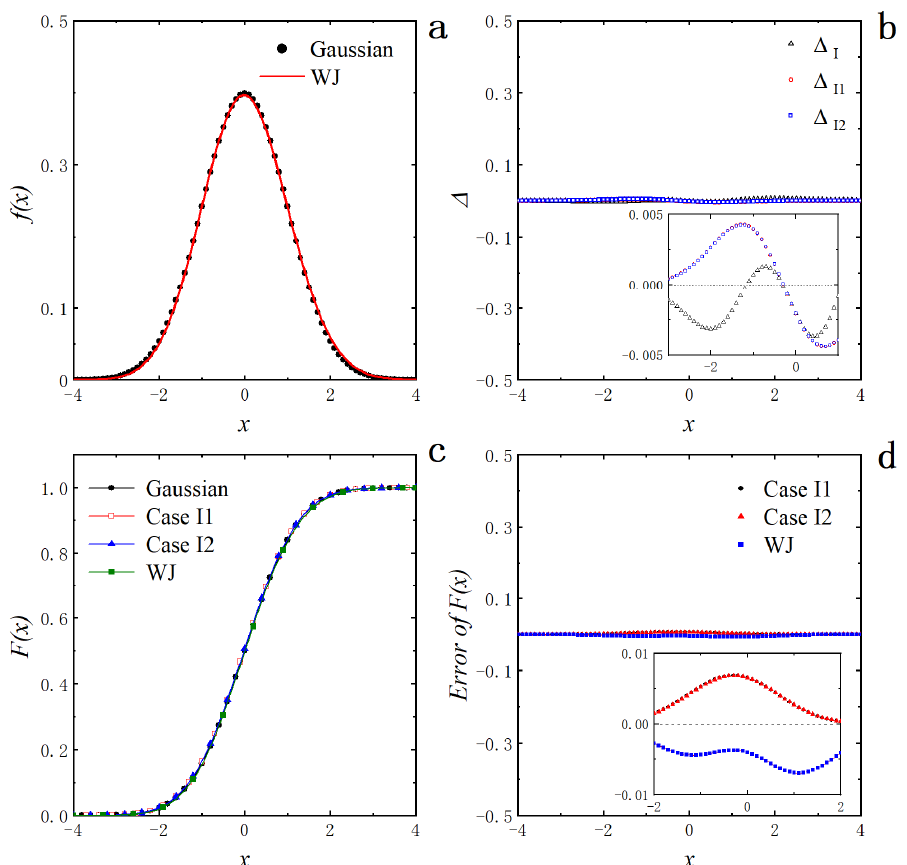
Figure 2. Analyses of expanding the WJ distribution based on Method I. ( a ) Scatter points of the standard normal distribution function (1b) at the intervals of 0.1 and fitting curve by the WJ function (2); ( b ) Symbols of ∆ I , ∆ I1 and ∆ I2 for the residuals of the WJ function, N ( ˆ µ I , ˆ σ I1 ) and N ( ˆ µ I , ˆ σ I2 ) relative to N(0,1) , respectively; ( c ) Signs of Gaussian, CaseI1, CaseI2 and WJ for the cumulative probability distribution functions of N(0,1) , N(̂ , ) , N(̂ , ) and the WJ function,